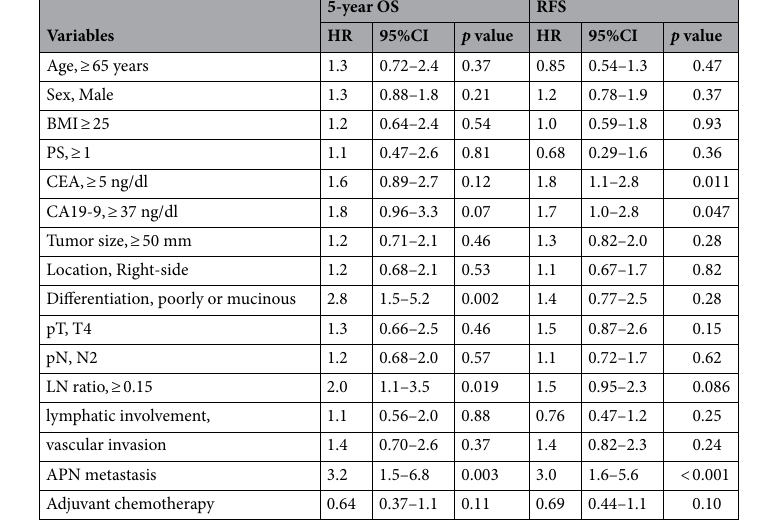
Table 2. Univariate analyses of risk factors for 5-year OS and RFS. OS: overall survival, RFS: relapse free survival, HR: hazard ratio, CI: confidence interval, BMI: body mass index, calculated as weight in kilograms divided by height in meters squared, PS: performance status, CEA: carcinoembryonic antigen, CA19-9: carbohydrate antigen 19-9, pT: pathological T stage, pN: pathological N stage, LN: lymph node, LN ratio: the number of metastatic LN divided by that of retrieved LN, APN: apical lymph node.